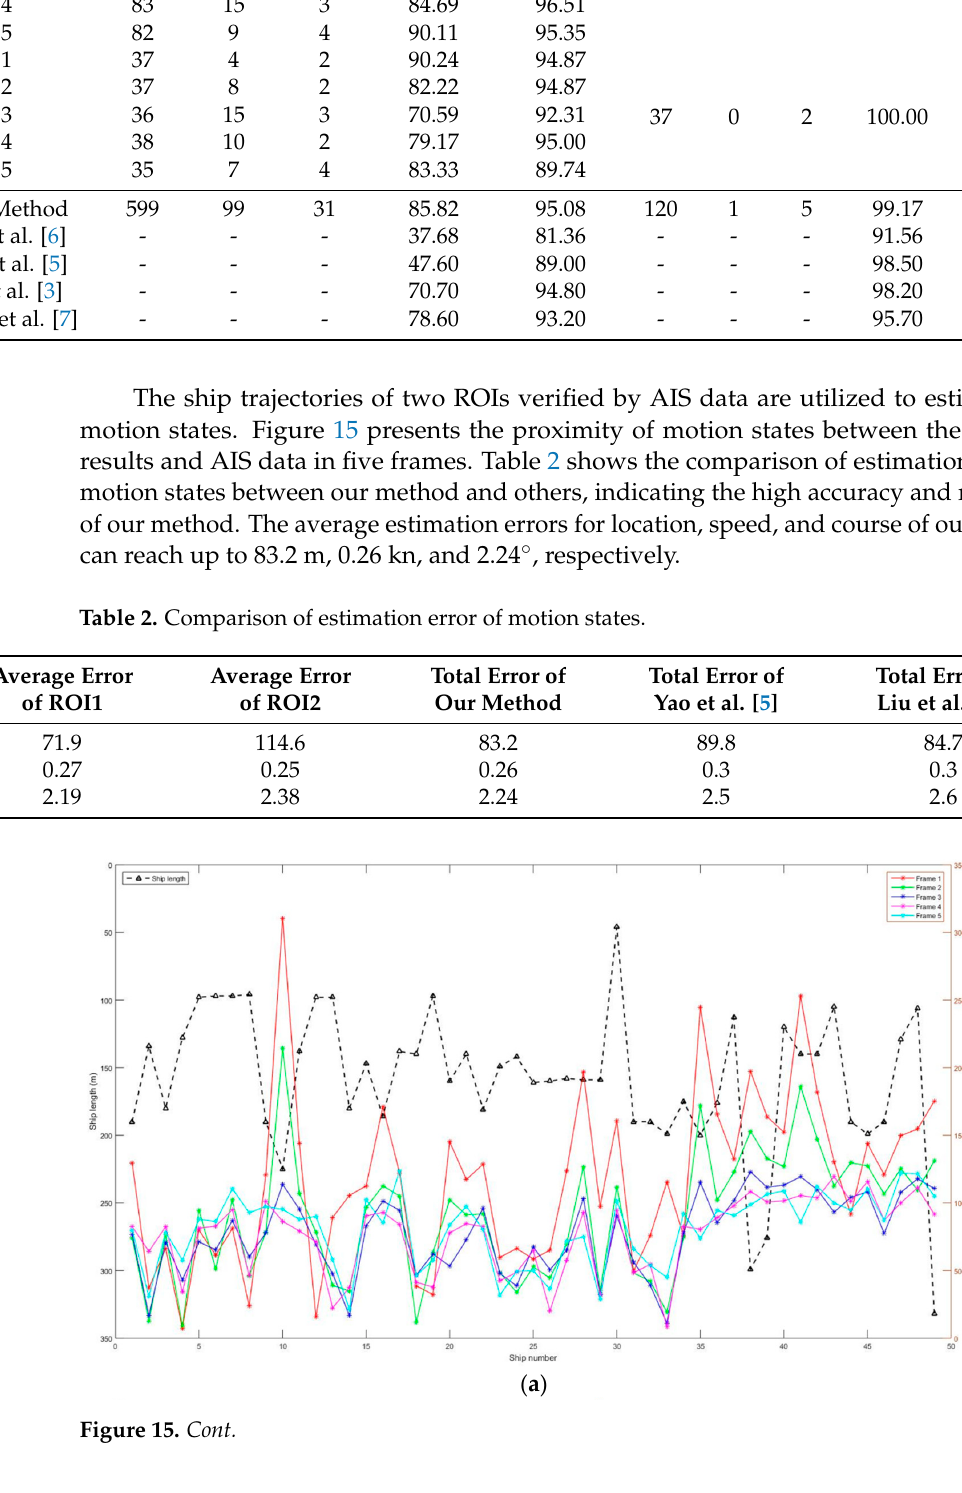
( c ) Figure 15. The proximity of motion states between the tracking results and AIS data in fi ve frames: ( a ) location error between estimated positions and AIS positions; ( b ) estimated speed with regard to AIS speed; ( c ) estimated course with regard to AIS course. Table 2. Comparison of estimation error of motion states. Estimation Er- ror Average Error of ROI1 Average Error of ROI2